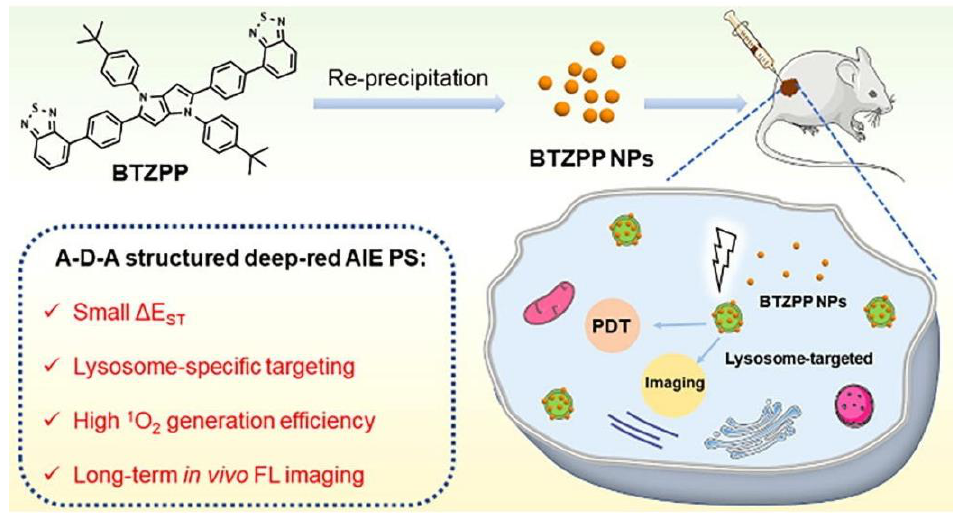
Figure 5. Schematic illustration of AIE-PSs (BTZPP) designed for long-term imaging. Reprinted with permission from Ref. [47]. Copyright 2022 Elsevier Ltd.